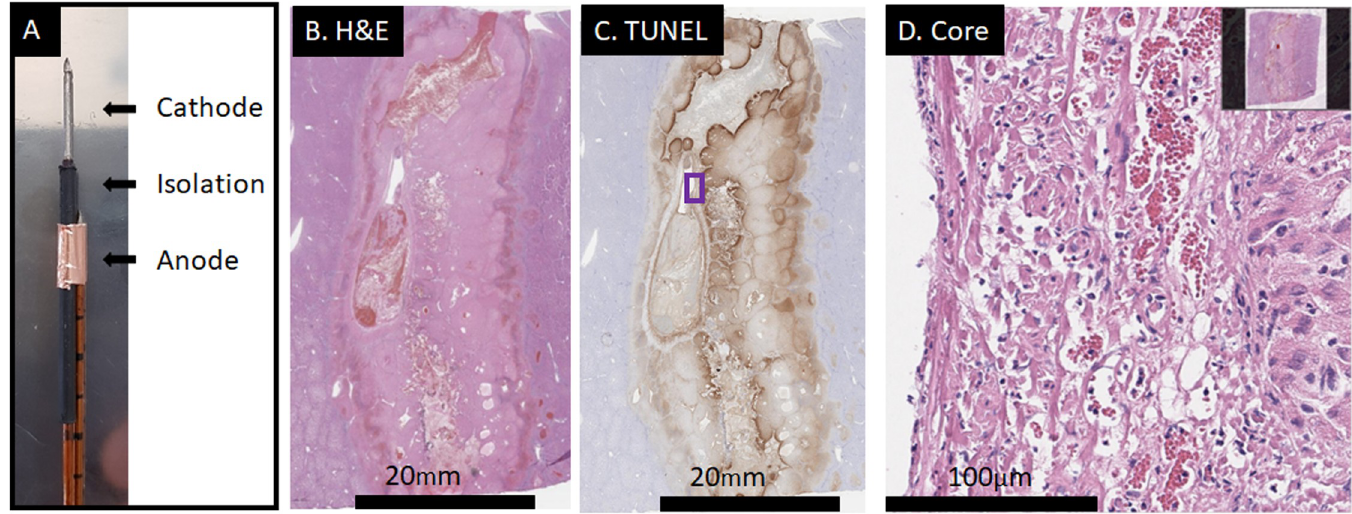
Fig 6. A successful ablation with a bipolar electrode. Applied were three E2 waveforms at 1200, 1100 and 1000V peak voltage and 293 μ F capacitance. Liver harvest was 18h post treatment. (A) The electrode prototype had lengths of 10-10-15mm for anode-isolation-cathode, respectively. (B) H&E staining of the entire lesion. (C) TUNEL- staining of the entire lesion. Both stains show a clean, closed lesion with a mixture of necrosis and significant apoptosis towards the margins.